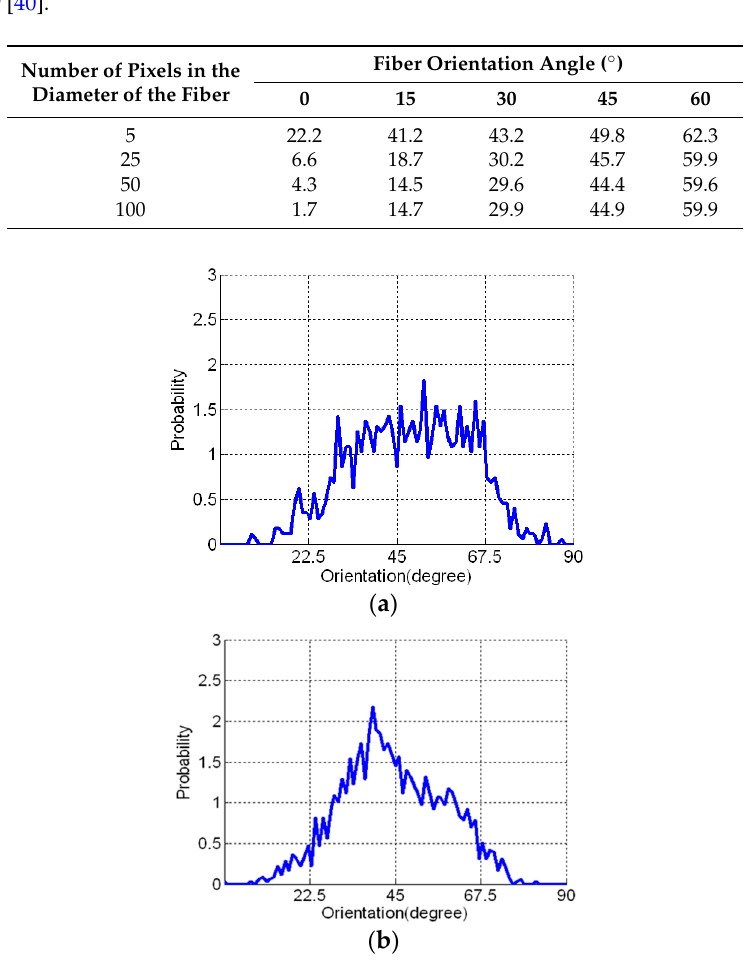
Figure 7. Fiber orientation distributions for the two different casting methods: ( a ) Method A; ( b ) Method